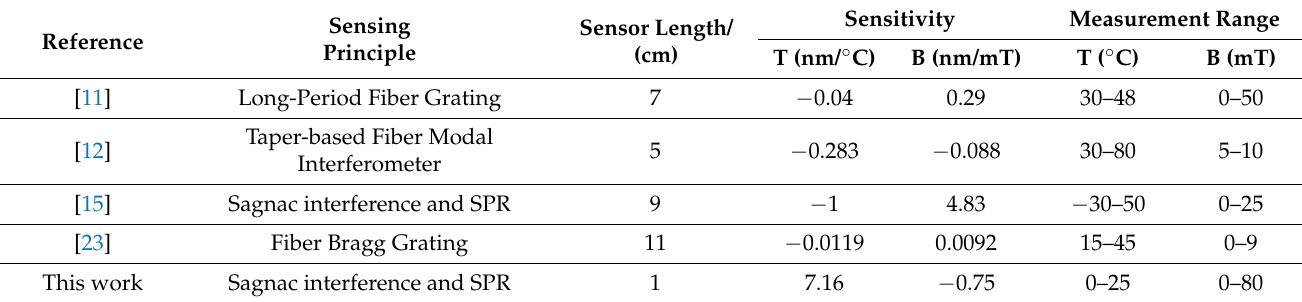
Table 2. Comparison of the proposed sensor and other published